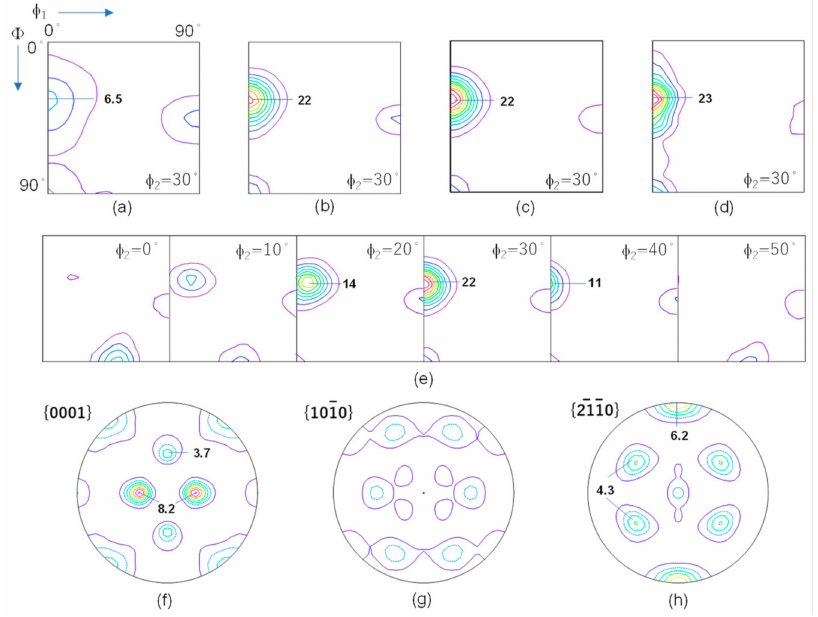
Figure 9. ( a – d ) ODF ϕ 2 =30 ◦ sections for predictions of β textures ( a ) without and ( b – d ) with variant selection. The conditions of prediction in Figure 9a–c are indicated by arrows a-c in Figure 8, respectively. ( e , f ) ODF sections and pole figures for the optimum prediction by DBOR shown in Figure 9c. ( a – c ) and ( e – h ) Predictions based on the observed β texture in Figures 3b and 4d–f and ( d ) prediction based on the predicted β texture in Figure 6d–h. Contour levels are ( a – e ) 2, 4, 6... and ( f – h ) 1, 2,